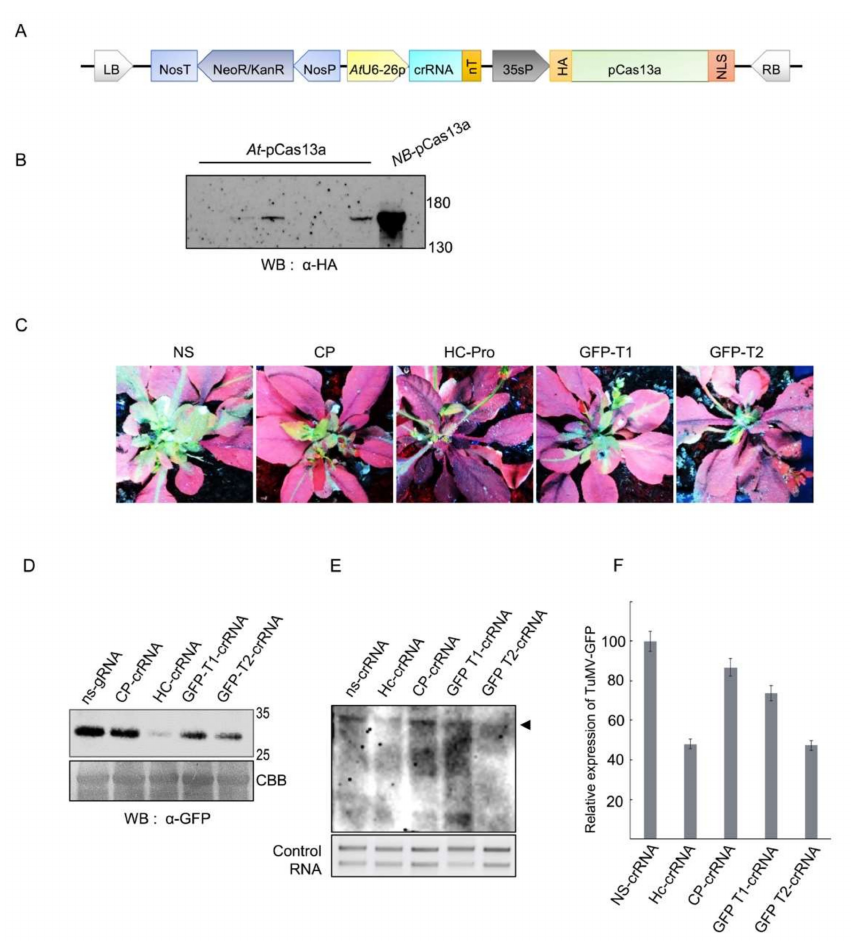
Figure 1. Cas13a interference with TuMV-GFP in A. thaliana plants. ( A ) Schematic representation of the engineered system for in planta expression. The T-DNA consists of pCas13a and crRNA driven by the 35s and AtU6-26 promoter, respectively. In addition, it also contains Kan r (kanamycin resistance) driven by the Nos promoter for selection of transgenic plants. ( B ) Confirmation of pCas13a protein expression in T 1 A. thaliana plants. Western blot analysis with anti-HA antibody was used to detect the expression of Cas13a in T 1 A. thaliana lines. NB-pCas13a represents protein extracted from transiently expressed pCas13a in Nicotiana benthamiana . ( C ) Interference of TuMV-GFP in pCas13a expressing transgenic Arabidopsis lines. Stably transformed Arabidopsis lines expressing pCas13 and crRNA were inoculated with TuMV-GFP sap from N. benthamiana . Plants were imaged for GFP fluorescence to examine TuMV-GFP systemic spread under UV light in the dark. ( D ) Western blot analysis to confirm TuMV-GFP accumulation in Arabidopsis systemic leaves. Protein resolved on 10% sodium dodecyl sulfate polyacrylamide gel electrophoresis (SDS-PAGE) was blotted with GFP antibody to detect virus accumulation. Coomassie brilliant blue (CBB) stained membrane (lower panel) was used as loading control. ( E ) Northern blot to analyze TuMV-GFP virus titer in plants. Northern blot confirms that Hc-crRNA and GFP-T2 crRNAs give better interference with TuMV-GFP followed by GFP-T1 and CP crRNAs. RNA blots from (C) were probed with a DIG-labeled TuMV complementary (250-nt) RNA fragment and detected with anti-DIG antibody. The arrow indicates the accumulation of the TuMV-GFP RNA genome. ( F ) Quantification of TuMV-GFP RNA genome. The graph represents the relative expression of the TuMV-GFP RNA virus as calculated on the bases of three independent biological replicates of northern blot. Error bars represents